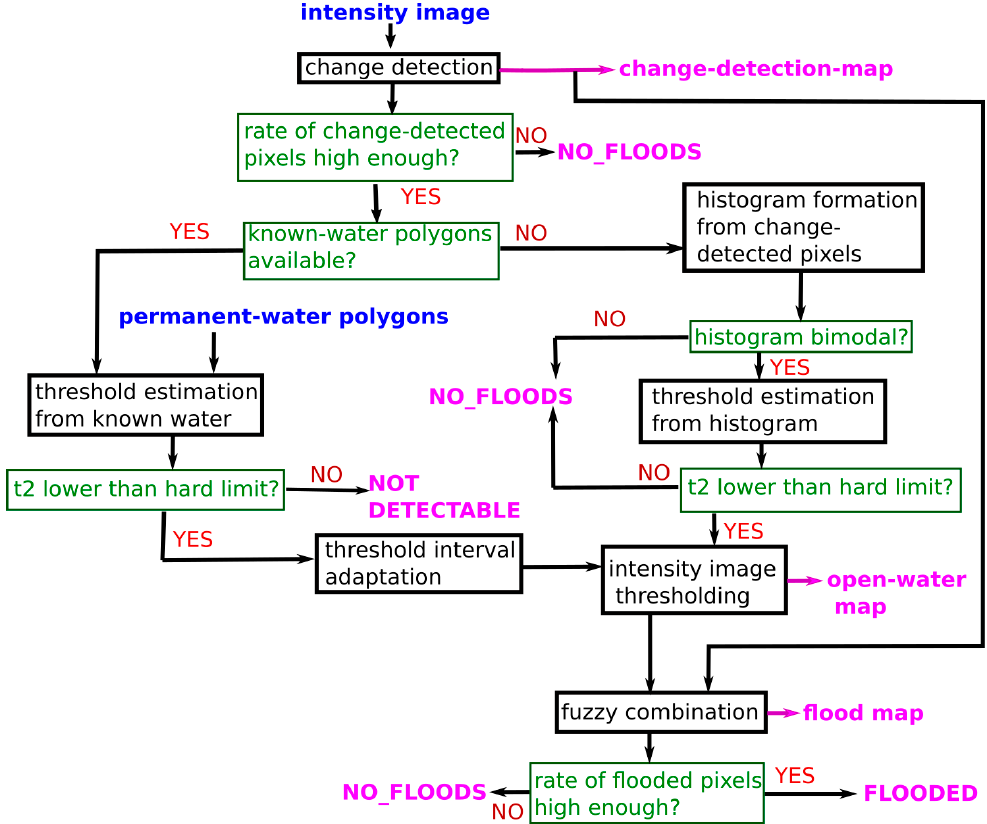
Figure 1. Flowchart of the designed flood detection processing chain. Blue colour text represents inputs; magenta colour text represents outputs (i.e., maps and output states (in uppercase)). Black rectangles indicate processing steps, while green rectangles indicate decisions (with red colour indicating possible choices).